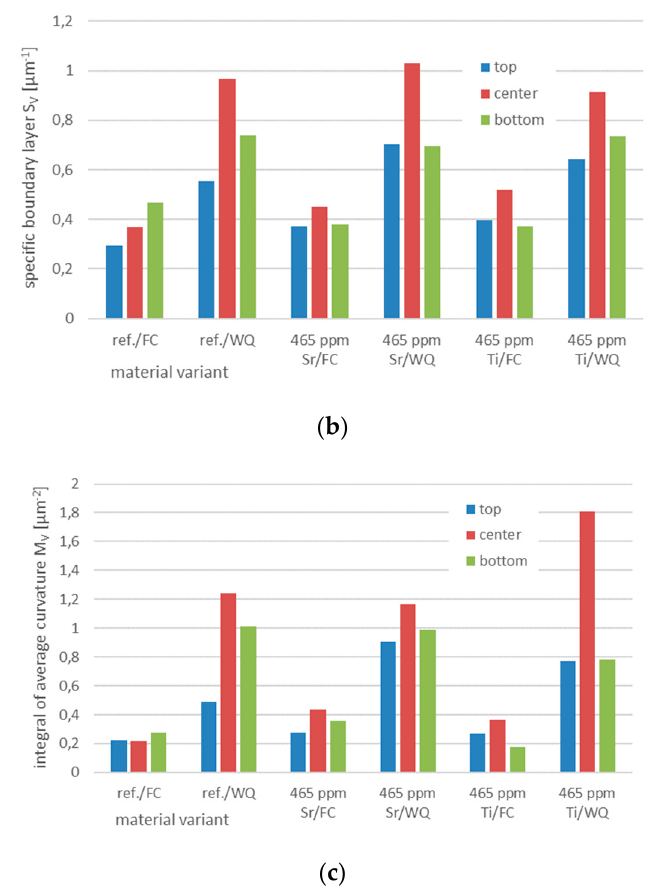
Figure 10. Foam microstructure, diagrams: ( a ) grain size as function of additive level and ( b, c ) geometrical characteristics of the eutectic phase as a function of cooling rate.